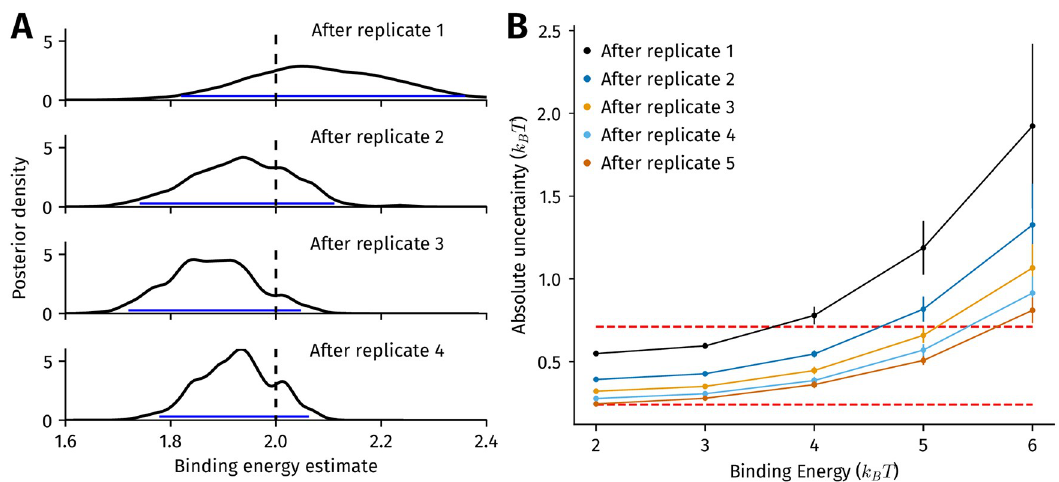
Fig 5. Impact of multiple biological replicates on uncertainty in binding energy estimates. (A) Posterior estimate of the binding energy at a single genomic locus after 1-4 replicates. The true binding energy of the locus is 2 k B T , indicated by the vertical dashed line. Four replicates of ChIP-seq were simulated, with the posterior density after each replicate, with the prior distribution set to be the default binding energy distribution employed in all our simulations (Methods). The blue lines indicate the absolute uncertainty of the binding energy estimate, which we define as the 95% Bayesian credible interval of the binding energy. This is calculated as the difference between the 2.5th and 97.5th quantiles of the posterior density. (B) The reduction in absolute uncertainty of posterior binding energy estimates of five locations, each with a different binding energy, after five replicates of ChIP-seq. The error bars are the standard deviation in estimates of the absolute uncertainty calculated after 100 trials; the filled circles represent the mean absolute uncertainty from these trials. The dashed red lines represent the values of absolute uncertainty required to distinguish between binding sites sequences that are a single mutation apart at least 50% of the time (upper,0.71 k ) and at least 75% of the time B T (lower,0.24 k B T